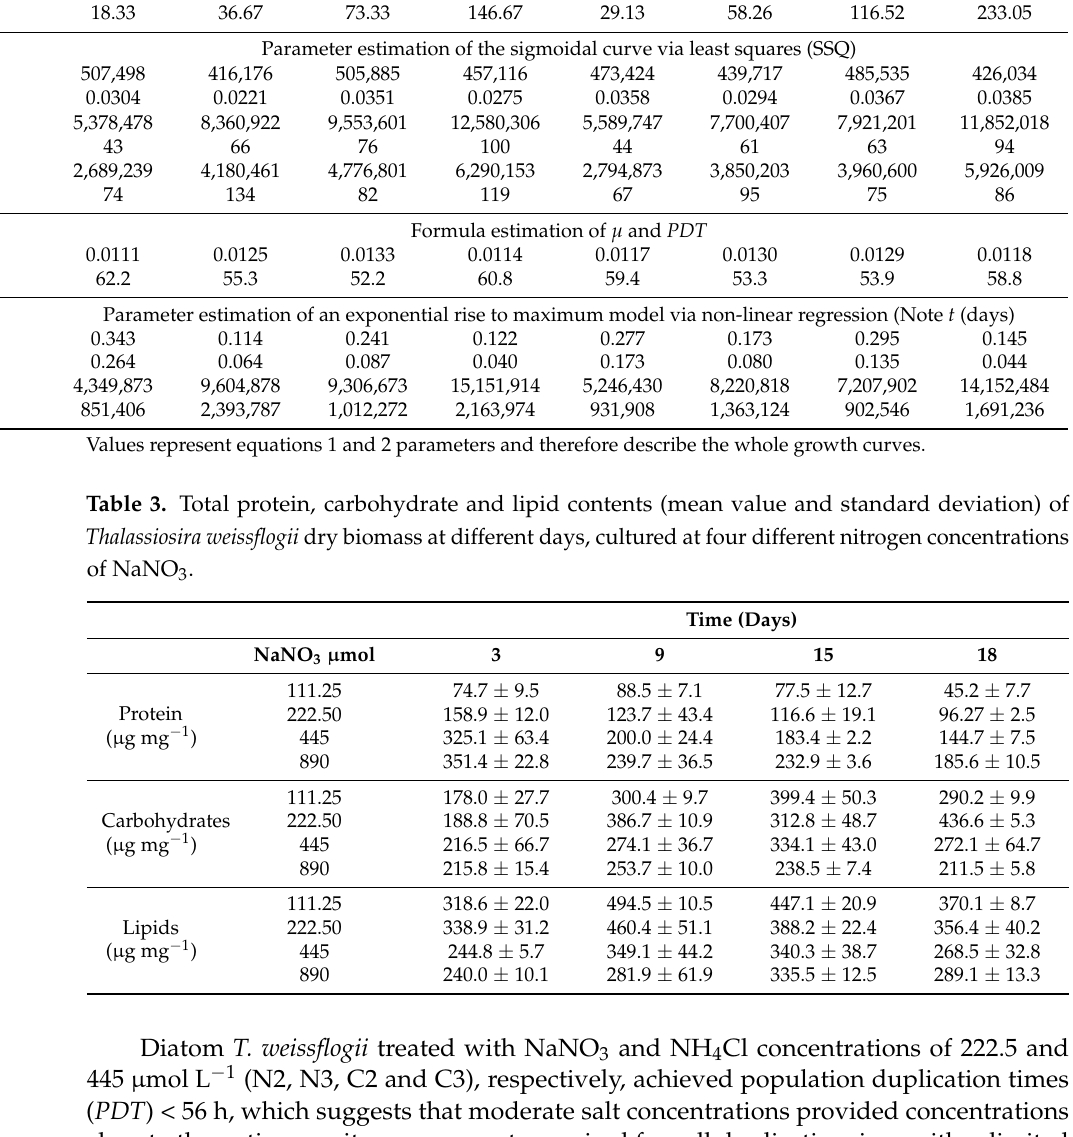
Table 2. Parameter estimations of Thalassiosira weissflogii growth curves with two different nitrogen sources at different concentrations via different models.